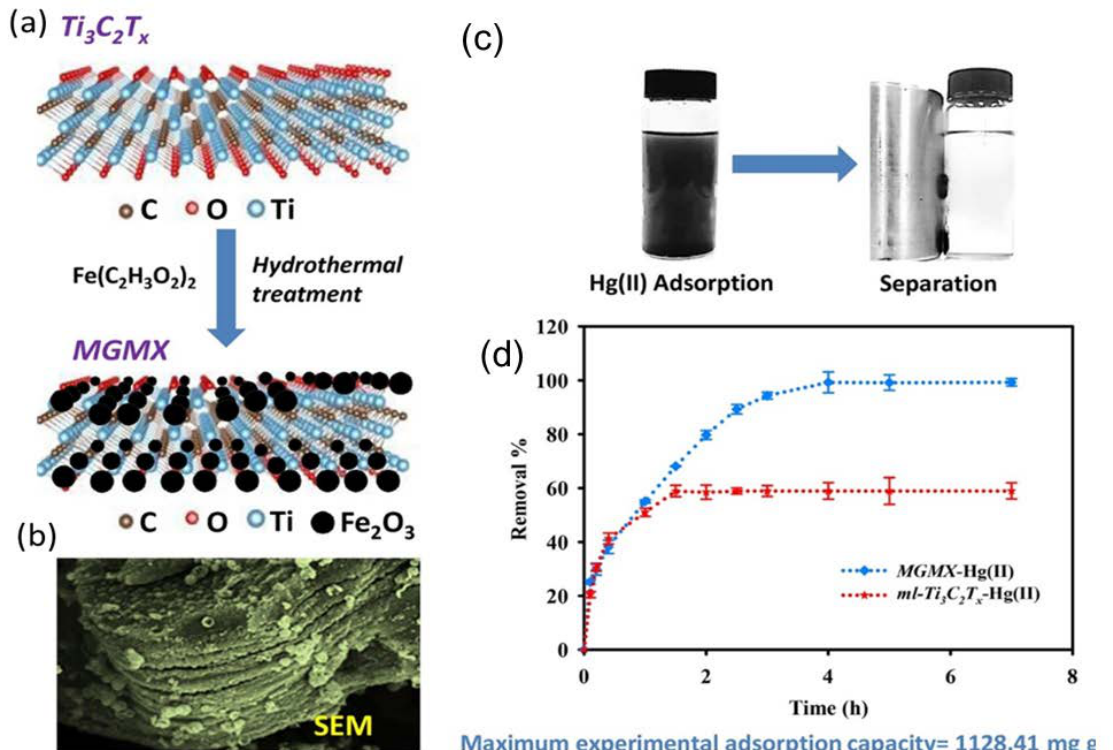
Figure 9. ( a ) Fast recovery mechanism after adsorption. ( b ) SEM image of magnetic titanium carbide ( Ti 3 C 2 T x ) MXene (MGMX) nanocomposite. ( c ) Photo for the magnetic separation adsorption efficiency of Hg(II) by ml–Ti 3 C 2 T x and that of the MGMX nanocomposite, and their removal efficiencies ( d ). Experimental conditions: 10 mg/L of Hg(II), 0.025 g/L of adsorbent at pH 6, and 298 K. Reproduced with permission from [61] . Copyright 2018 Elsevier.